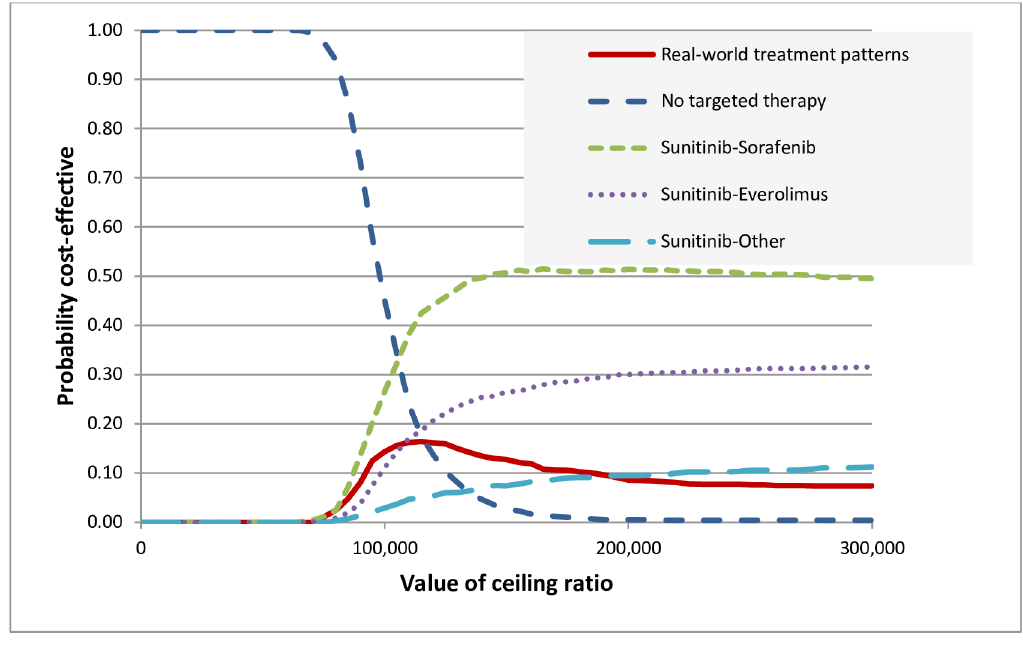
Fig 4. Cost-effectivenessacceptability curves representing the probability that each treatment strategyis cost-effective for a given maximum willingness-to-pay threshold per QALY gained.